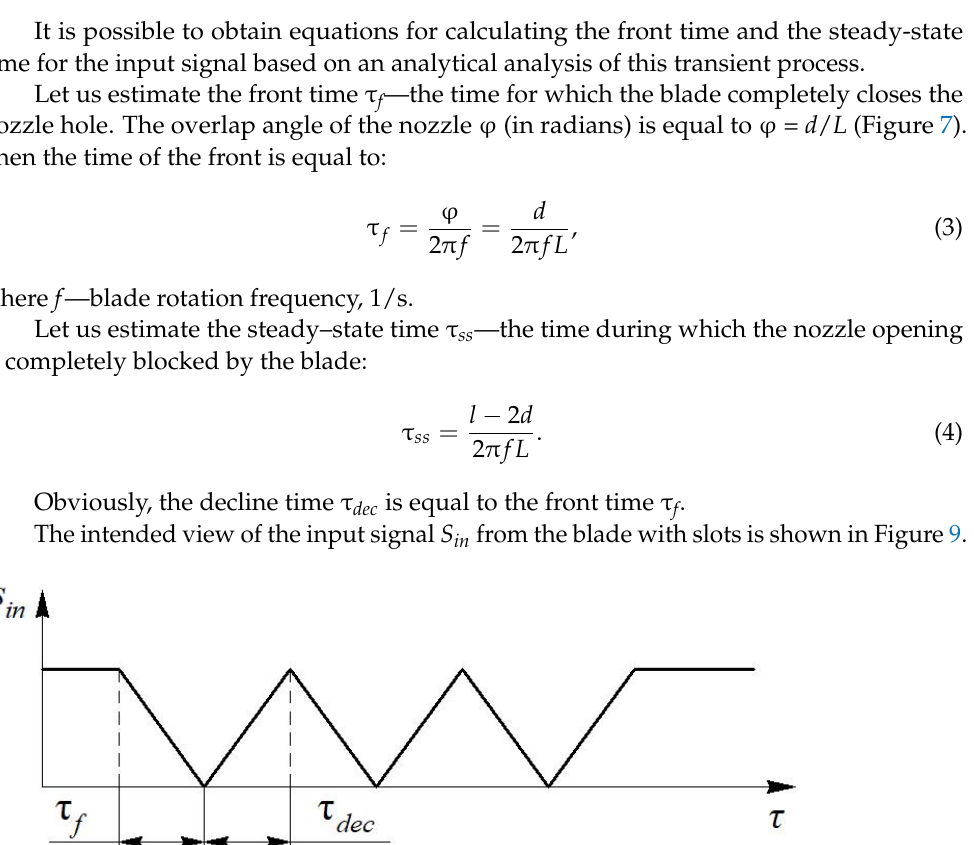
Figure 8. View of the input signal S in in time τ during dynamic calibration of the measuring system using a one–piece blade.